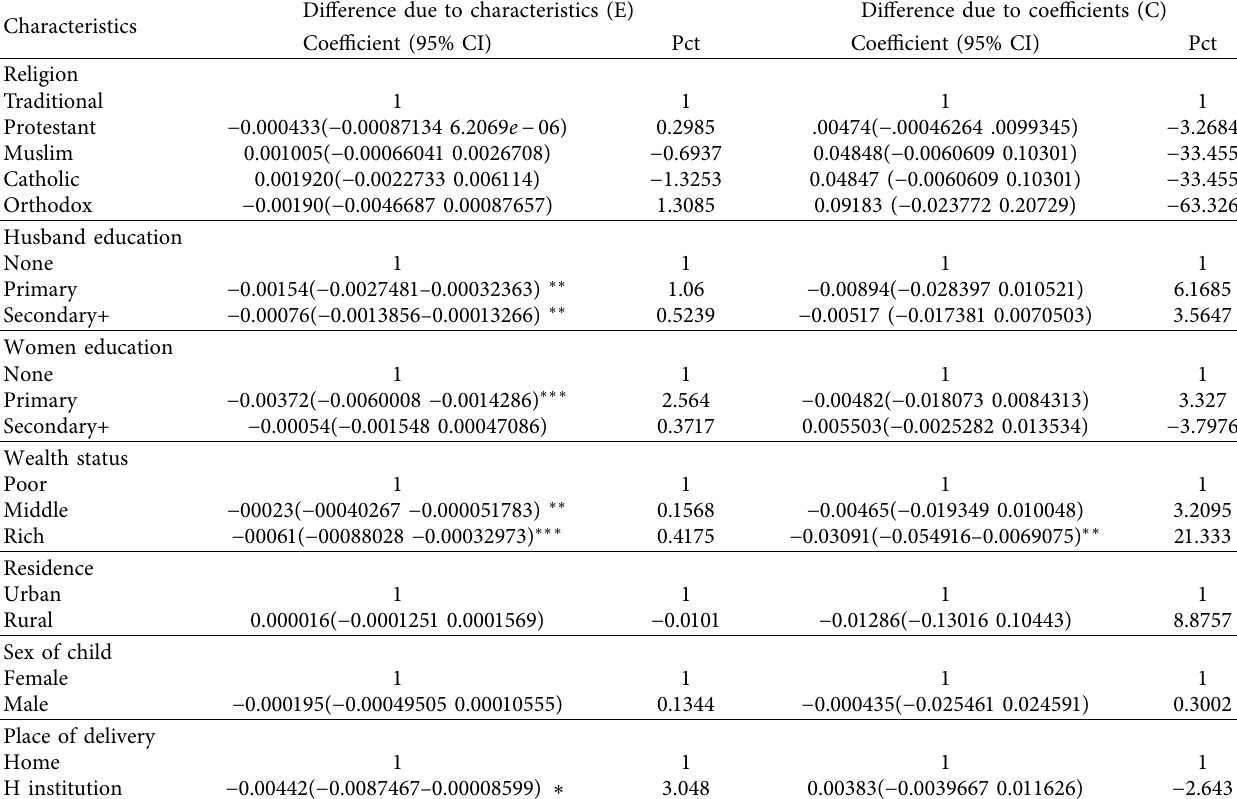
Table 4: Decomposition of change in underweight among children under five years in Ethiopia, 2005 to